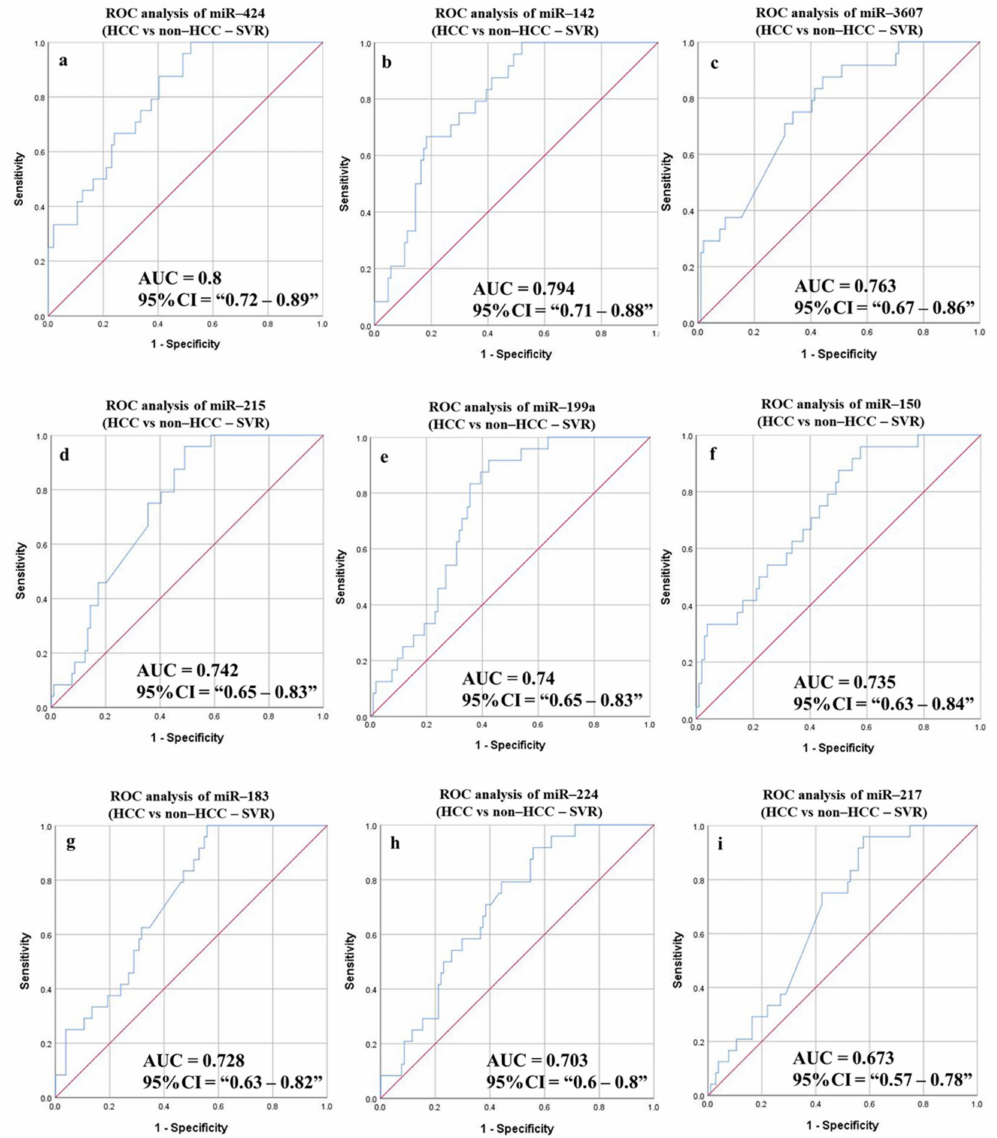
Figure 9. ROC curves and AUC for the DE-miRNAs to differentiate between HCC (SVR) patients and non-HCC (healthy controls, non-cirrhotic (SVR), and cirrhotic (SVR) HCV patients). The diagnostic potential and AUC of nine DE-miRNAs [( a ) miR-424 ( b ) miR-142 ( c ) miR-3607 ( d ) miR-215 ( e ) miR- 199a ( f ) miR-150 ( g ) miR-183 ( h ) miR-224 and ( i ) miR-217] were